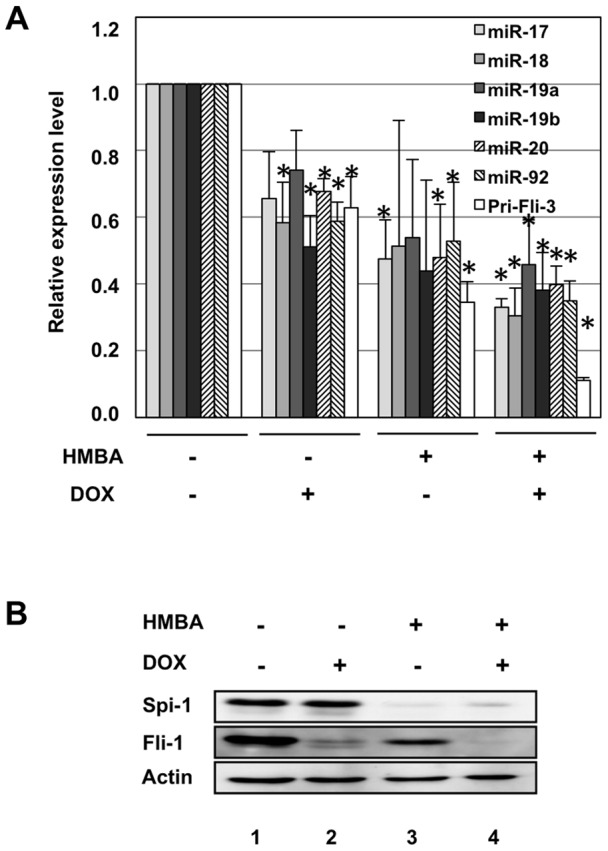
miR-17-92 expression correlates with ETS transcription factors Spi-1 and Fli-1 decrease during 745A#44 cells differentiation.A: As indicated, 745A#44 cells have been treated for two days with or without Dox to induce Fli-1 knockdown and for two other days in the same conditions with or without addition of 5 mM HMBA to induce differentiation associated with Spi-1 extinction. Pri-miRNA-17-92 transcript and mature miRNAs levels were then determined by semi-quantitative real-time RT-PCR using actin mRNA or U6 RNA as reference, respectively. The upper panel shows relative transcripts levels following Dox and/or HMBA treatment normalized to untreated cells levels (means and standard deviations from 3 independent experiments). Asterisks show significant differences compared to the untreated condition (t-test, p<0,05). B: Typical results of a Western blot analysis of Fli-1 and Spi-1 protein levels after treatments used in A.